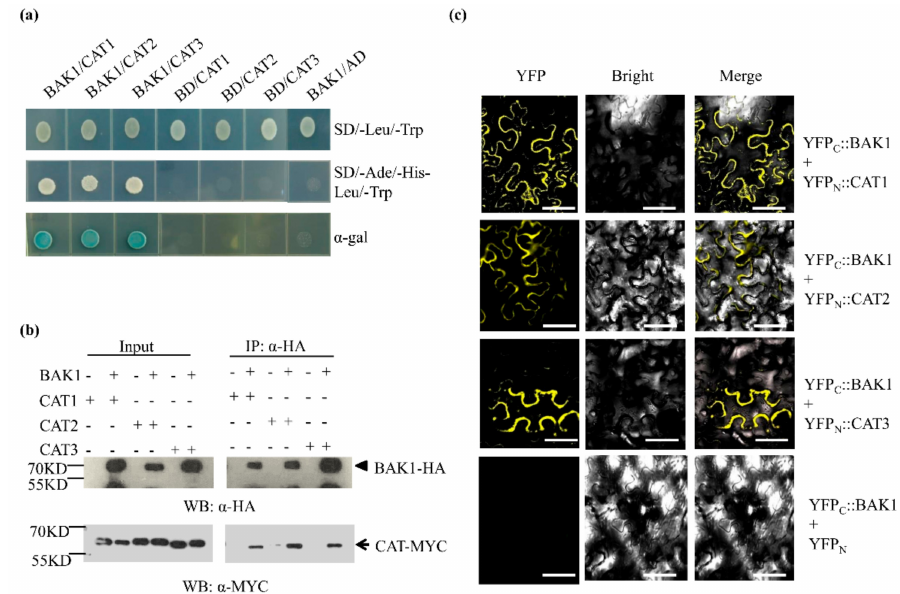
Figure 4. BAK1 interacts with three catalases. ( a ) Yeast two-hybrid assay of BAK1 interaction with Catalase 1 (CAT1), CAT2, and